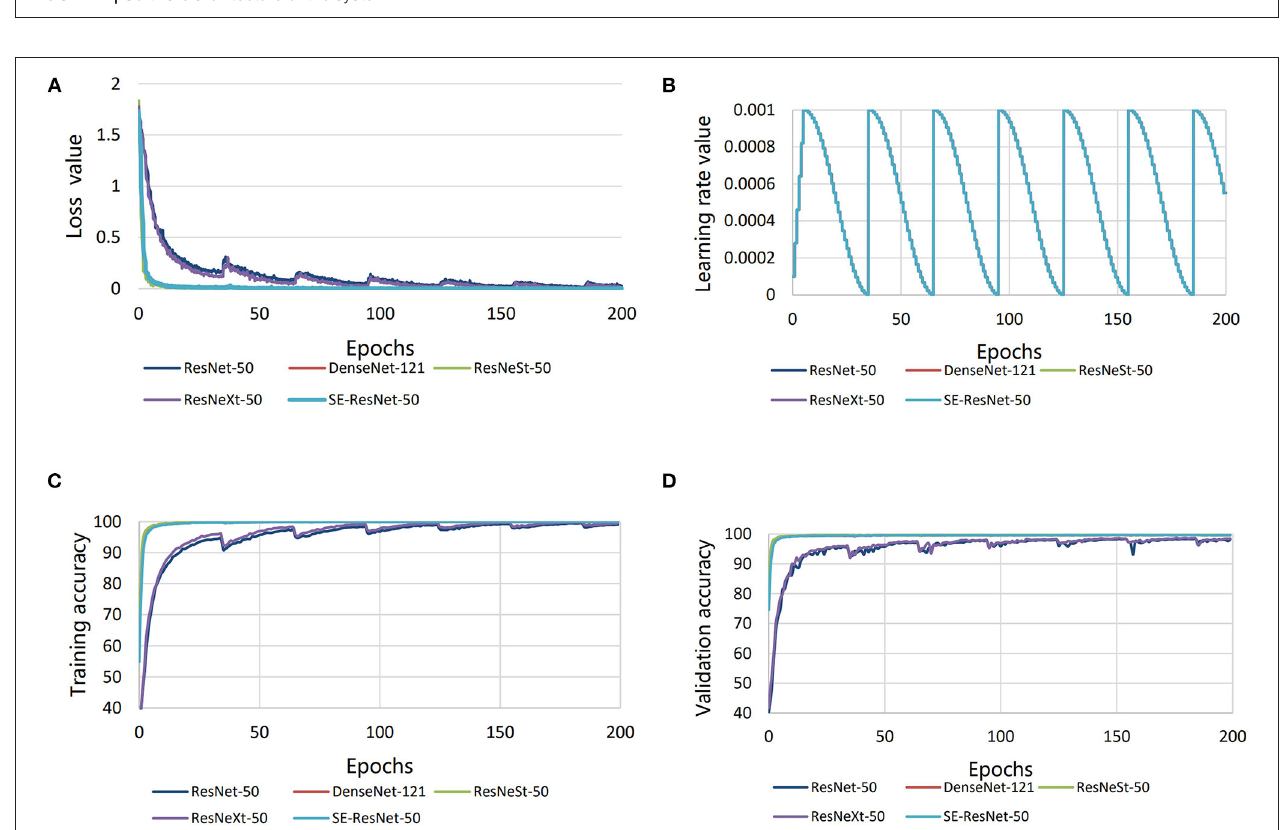
FIGURE 5 | Comparisons in performance of the five different submodels. (A) Loss value, (B) learning rate, (C) validation accuracy, and (D) training